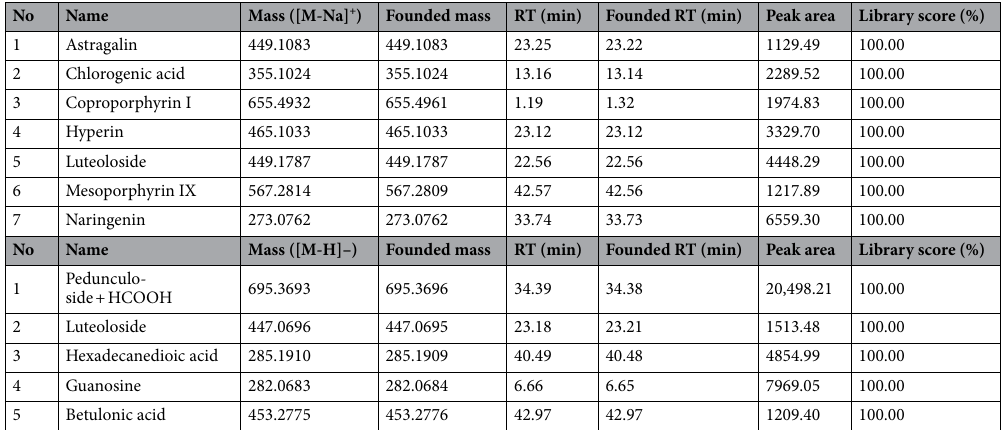
Table 2. Phytochemical components identified in the stem bark of P. africana methanolic extract by LC-TOF– MS analysis.